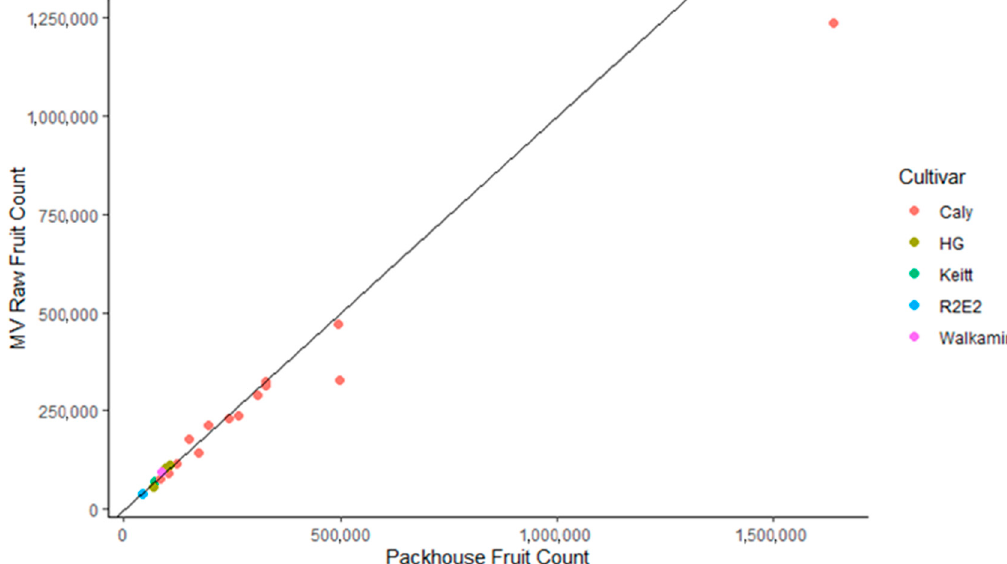
Figure 6. Scatter plot of raw multi-view machine vision estimates of 2019–2020 orchard fruit load against packhouse records, n = 20. Data is fitted by a linear regression model, R 2 = 0.98, slope = 0.74 and p < 0.001.